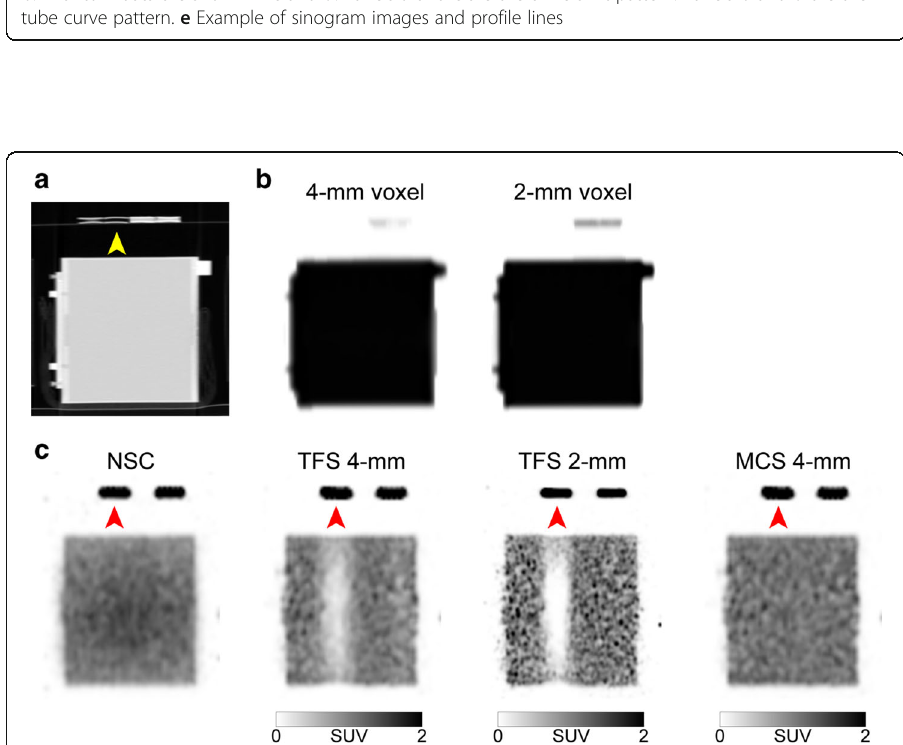
Fig. 7 Sagittal images of a phantom (urine shift pattern). CT image ( a ), 4-mm and 2-mm voxel μ -maps ( b ), PET images with non-scatter-correction (NSC), TFS 4-mm, TFS 2-mm, and MCS 4-mm ( c ). Yellow arrow : urinary catheter in a CT − /PET+ region. Red arrows : 18 F-FDG solution in a urinary catheter in a CT − /PET+